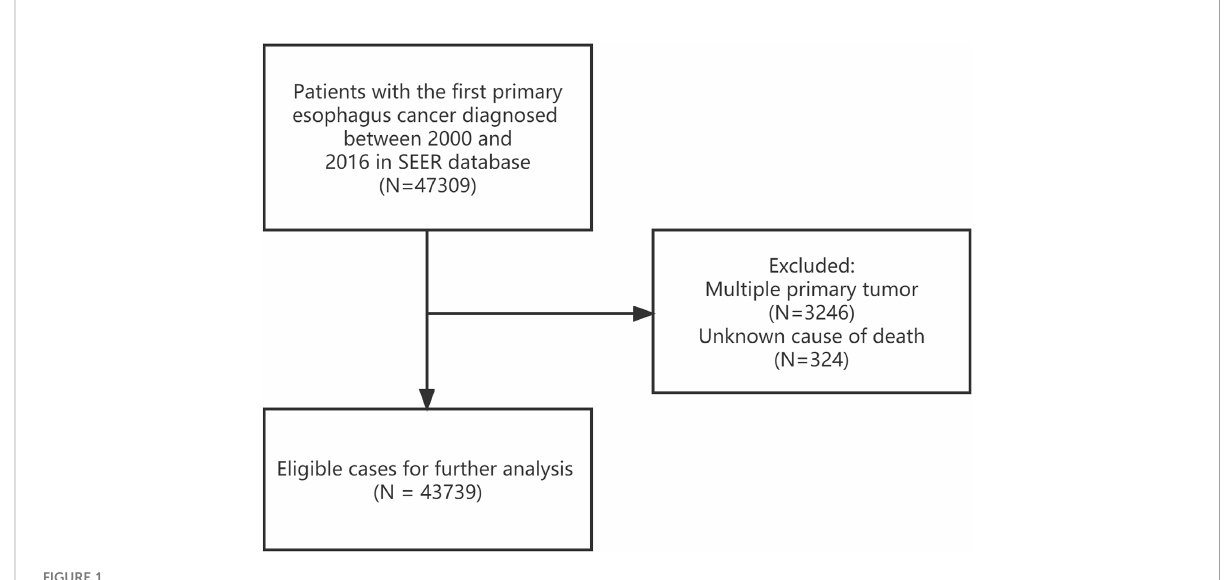
FIGURE 1 Inclusion and exclusion fl